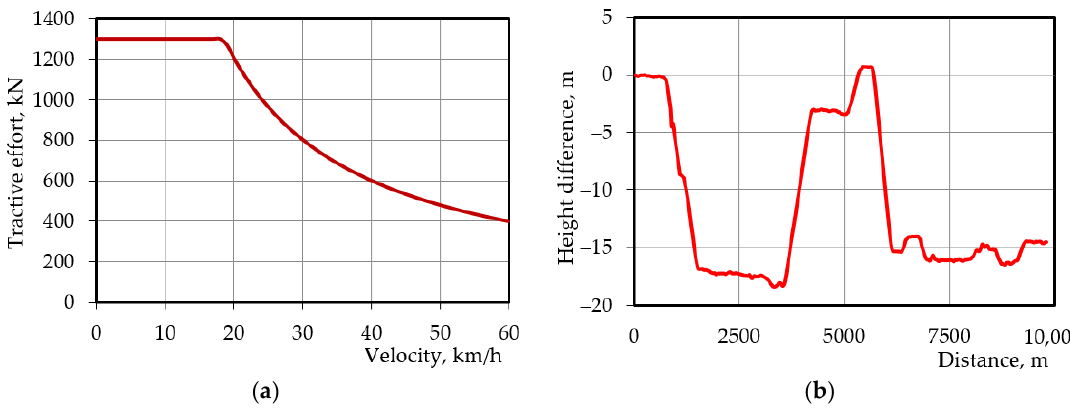
Figure 3. Traction characteristics of the electric locomotive ( a ) and profile of the track section ( b ). The dependence of the tangential power for a full flight is shown in Figure 4.